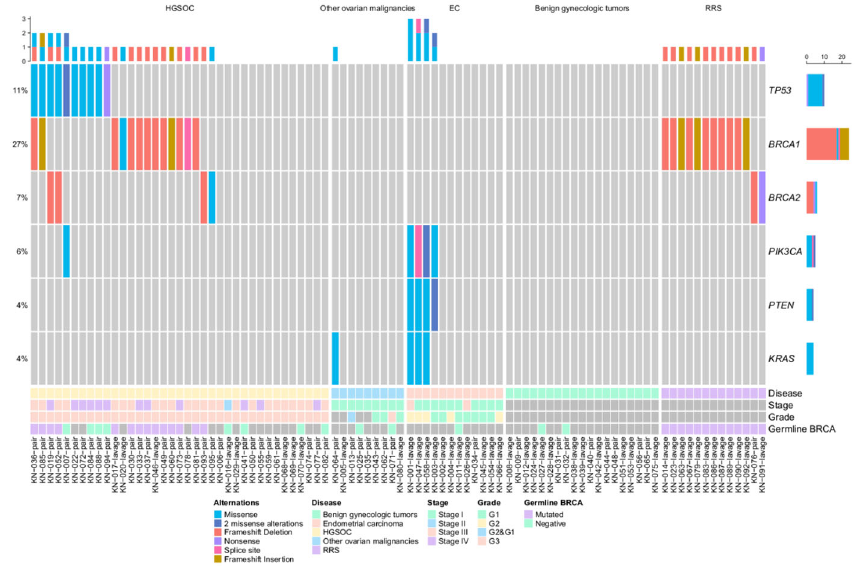
Figure 2. OncoPrint of uterine cavity lavage samples. EC–endometrial cancer.